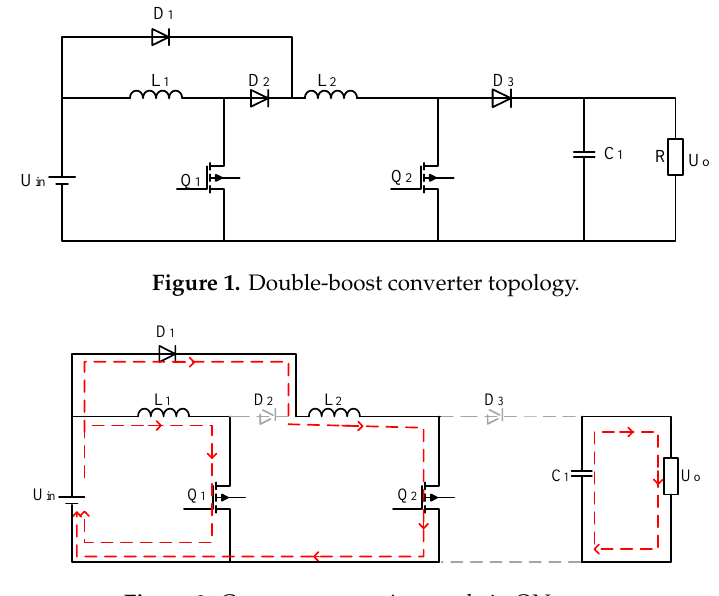
Figure 2. Converter operating mode in ON state.